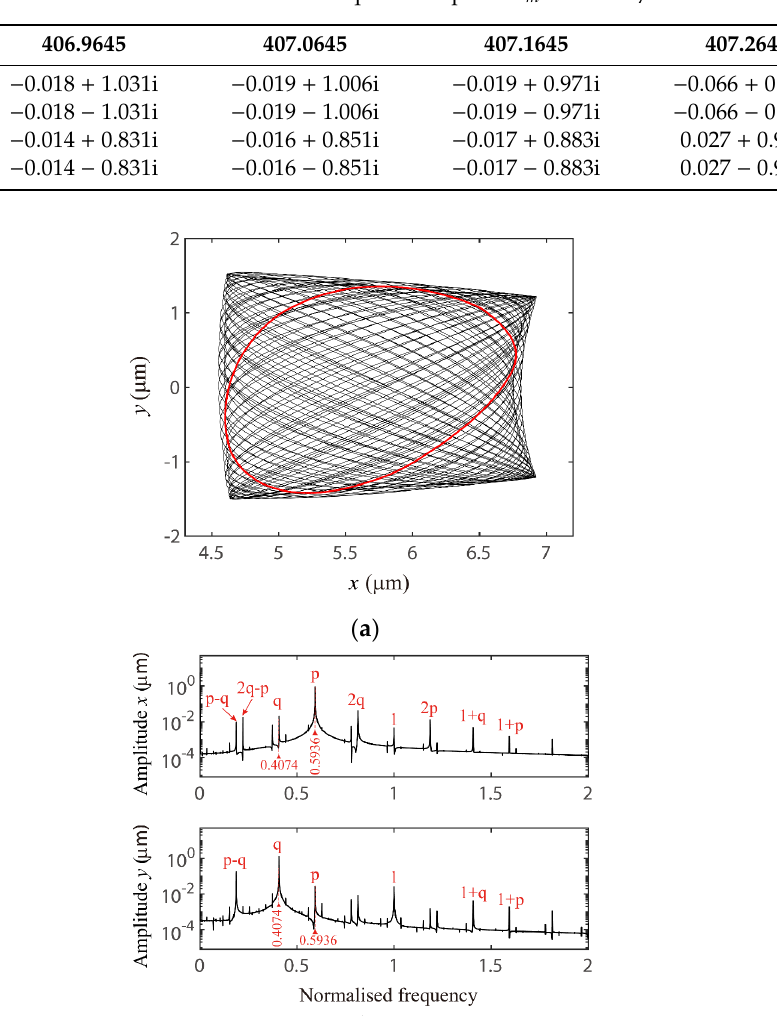
Table 4. Period-1 motion Floquet multipliers λ m around B 7 .